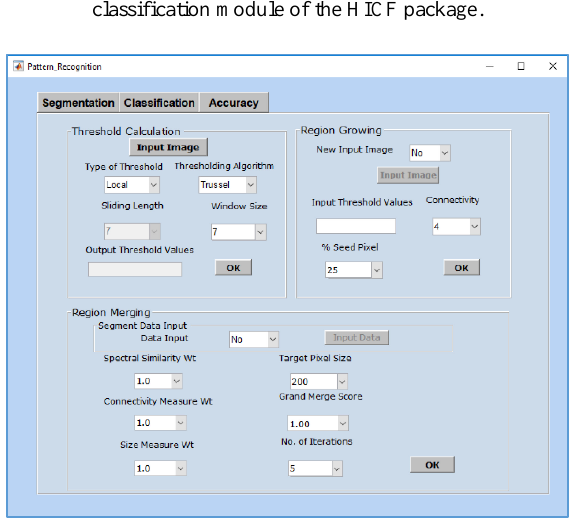
Figure 12. Pattern recognition interface for unsupervised classification in the HICF package.